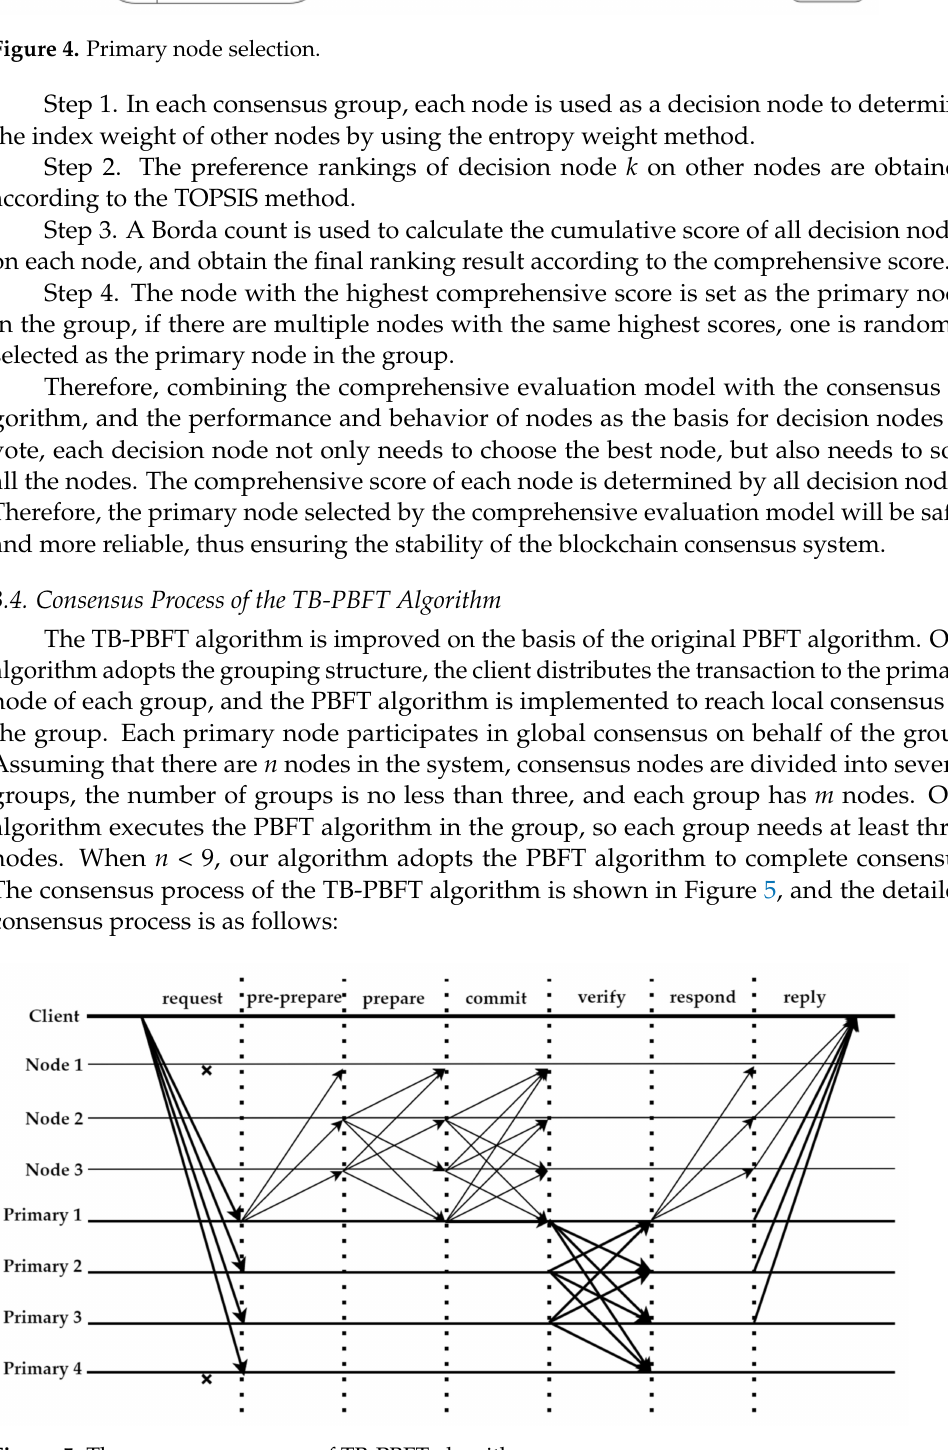
Figure 5. The consensus process of TB-PBFT